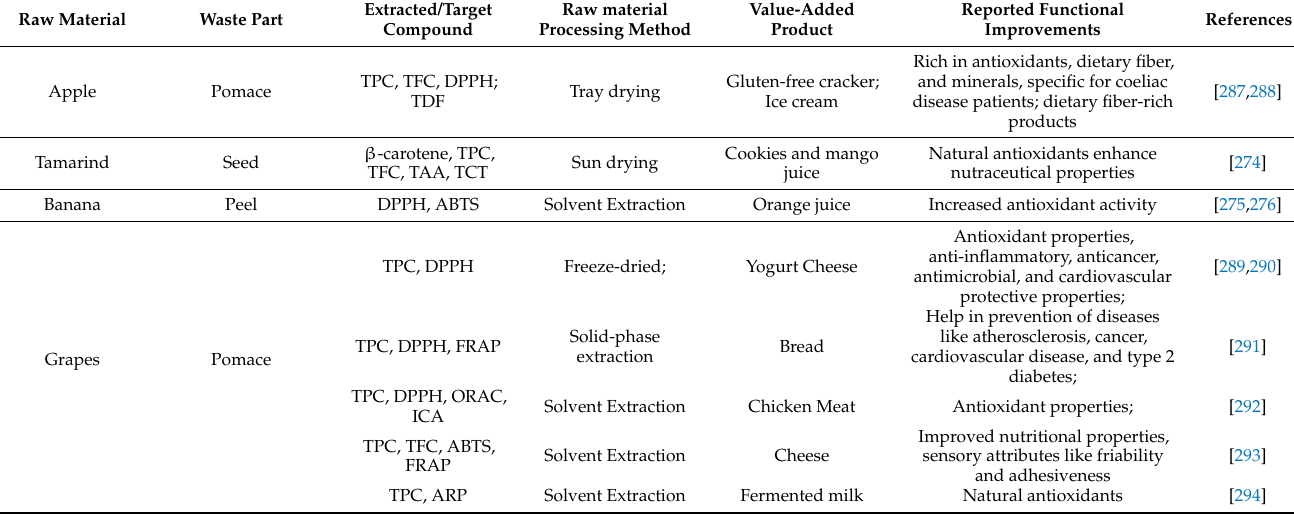
Table 5. Development of value-added food products from different waste parts of fruits and